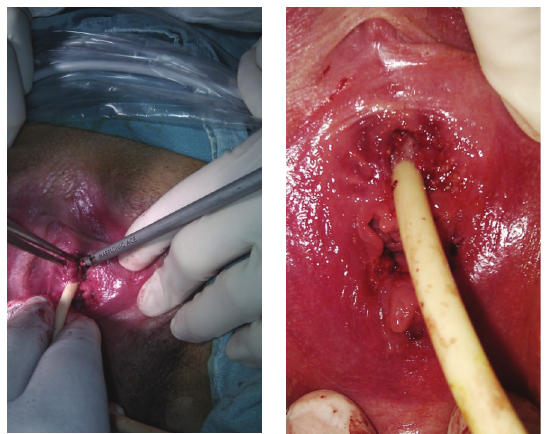
Figure 2: The excision of GCA using HS and appearance after the